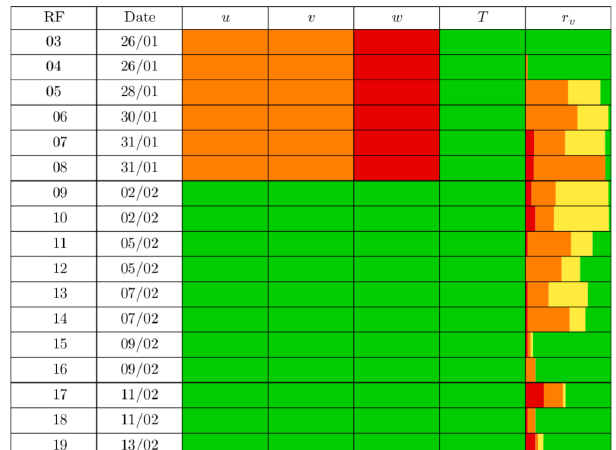
Figure 14. Quality flags associated with the turbulent data for each SAFIRE ATR 42 flight during the campaign. The data qual- ity increases from red (poor quality) to orange, yellow and green (high quality). For moisture and temperature, the flag is the com- bined flag described in Sects. 4 and 5, considering the short legs of L3